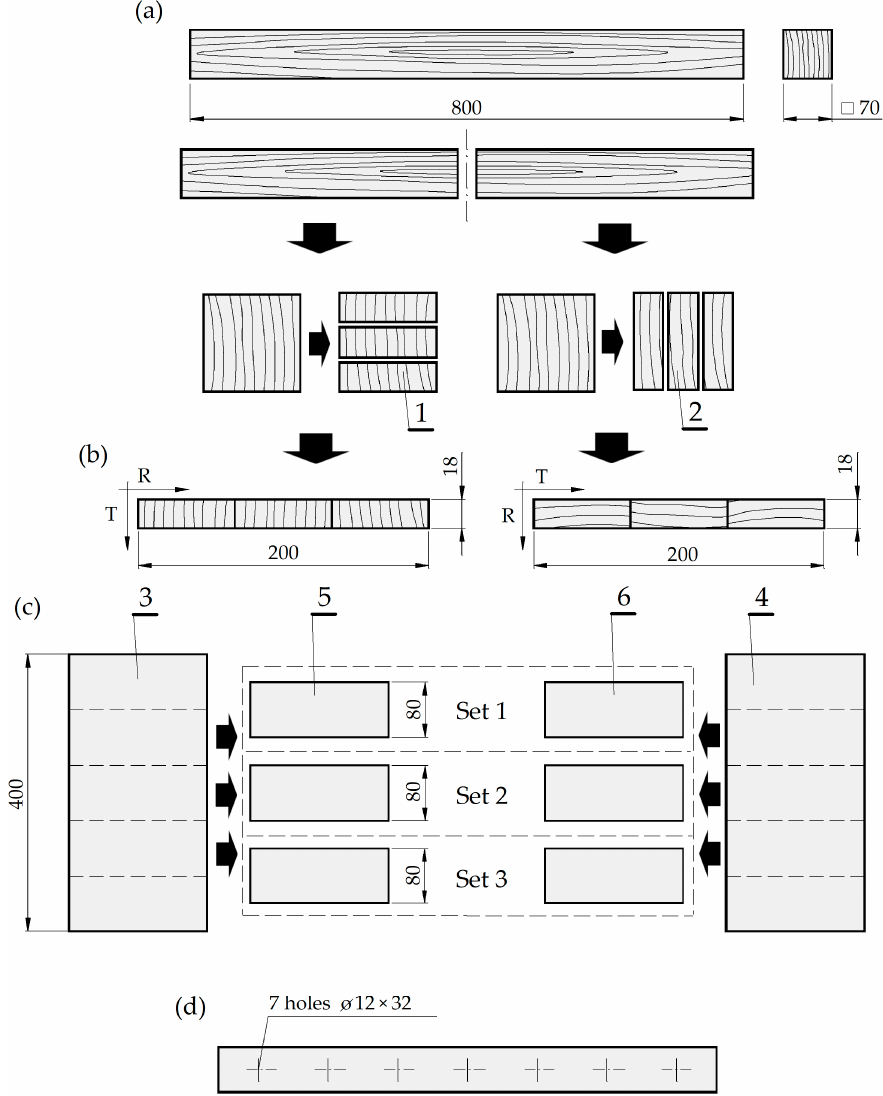
Figure 2. Scheme of samples preparation: ( a )—initial cutting, ( b )—assembling and gluing radial (R) and tangential (T) grain pattern blank, ( c )—final cutting of samples sets, ( d )—the holes drilling pattern in the narrow side of the sample, (1, 2—radial and tangential pieces of blank, respectively, 3, 4—radial and tangential grain pattern blank, respectively, 5, 6—final radial and tangential twin samples, respectively, T, R—tangential and radial anatomical direction, respectively; the dimension in mm).